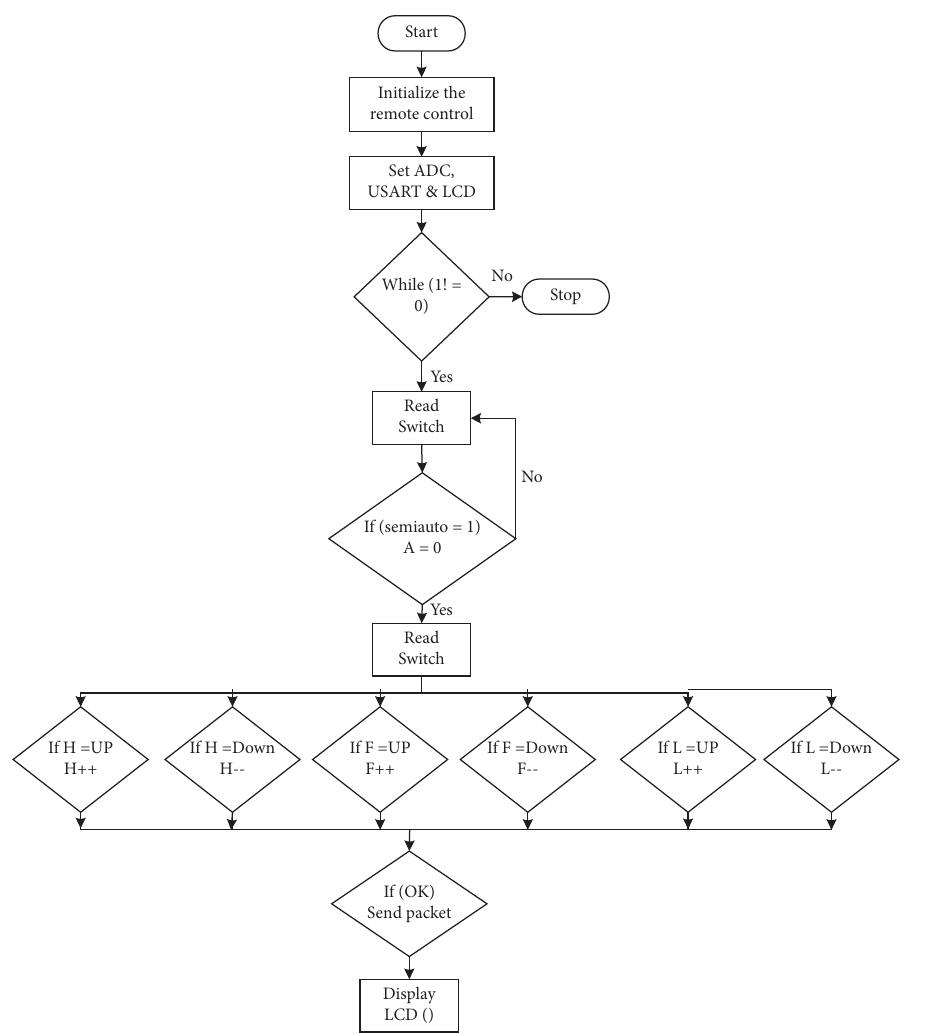
Figure 7: Flowchart for remote control in semiautonomous